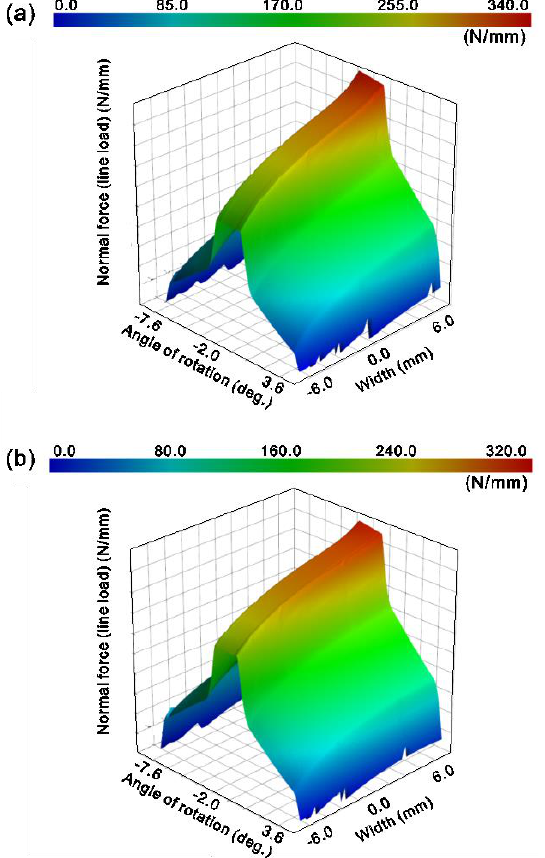
Figure 9. Comparison of contact patterns when torque is 140 Nm. ( a ) f G = 0 Hz (static stiffness) and ( b ) f g = 500 Hz (dynamic stiffness). Table 3. Numerical cases.